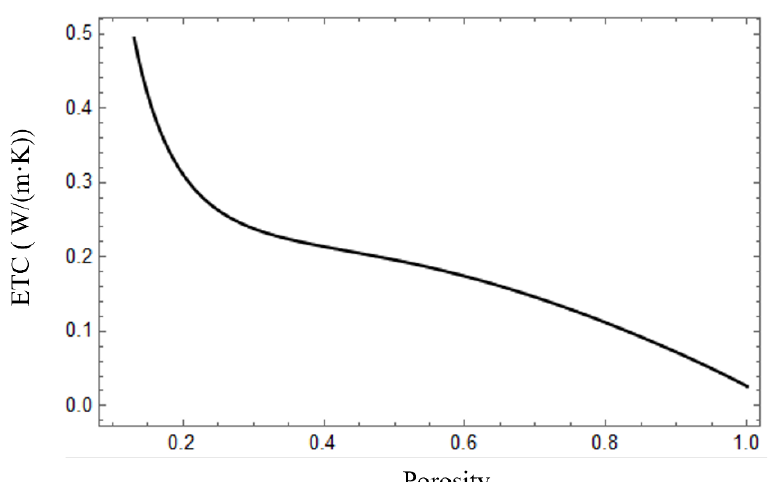
Figure 11. The variation of the ETC with porosity.